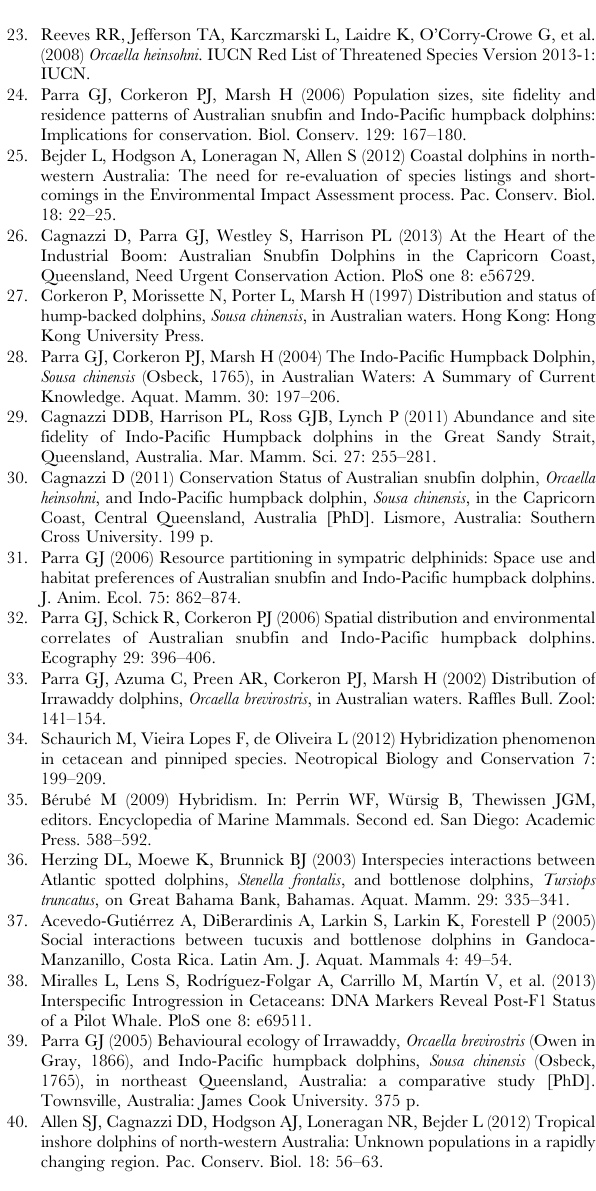
Table S3 P values (from Wilcoxon sign-rank test) and presence of mode shifts indicating whether dolphins have recently undergone a bottleneck at our sampling locations. Visualisations of potential mode shifts are shown in Figure S3. H : heterozygosity; IAM: infinite allele model; SMM: stepwise mutation model; *statistically significant result ( P , 0.05): " assessed by BOTTLENECK. Table S4 Genotype data for snubfin, humpback and hybrid dolphins. OH =snubfin dolphin, SC = humpback dolphin, CY= Cygnet Bay, DA= Dampier Archipelago, EX=- North West Cape, RB= Roebuck Bay, H= hybrid dolphin.